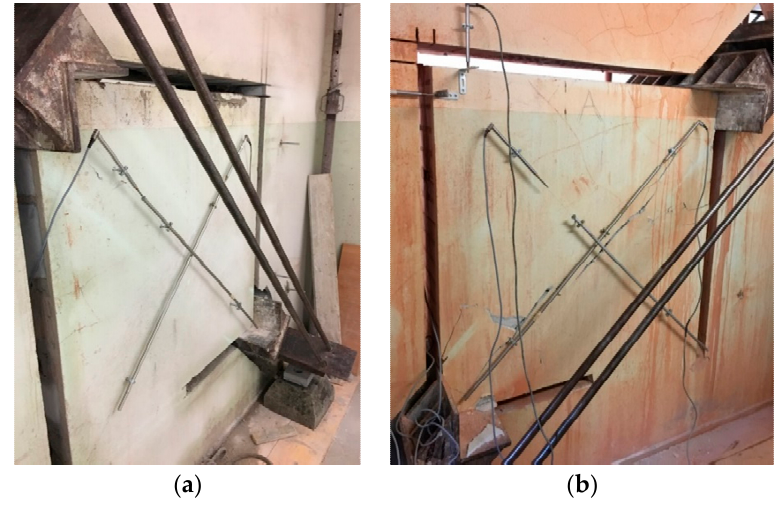
Figure 10. Shear tests (rendered wall panels): ( a ) L-07-S; ( b ) L-08-B.